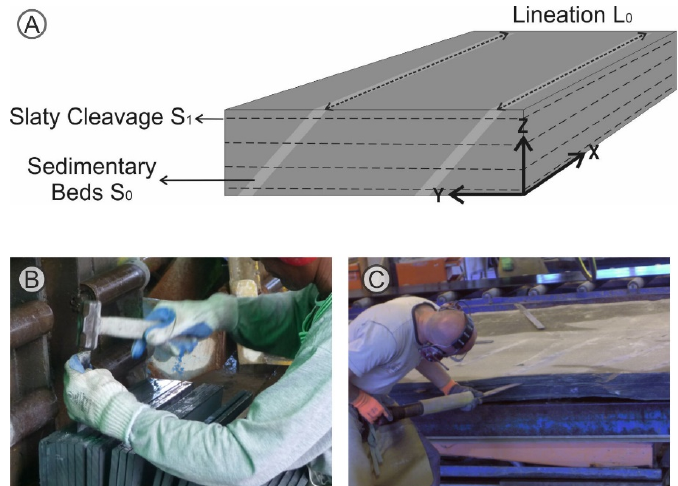
Figure 1. Relationships between sedimentation (S 0 ), slaty cleavage (S 1 ), and their intersection. ( A ) slate shingles are cut with their length parallel to lineation (L 0 ), in order to achieve optimal mechanical resistance; ( B ) splitting with a hammer and chisel in Minas Gerais, Brazil; and ( C ) splitting Alta quartzite with a pneumatic hammer in Alta, Norway.